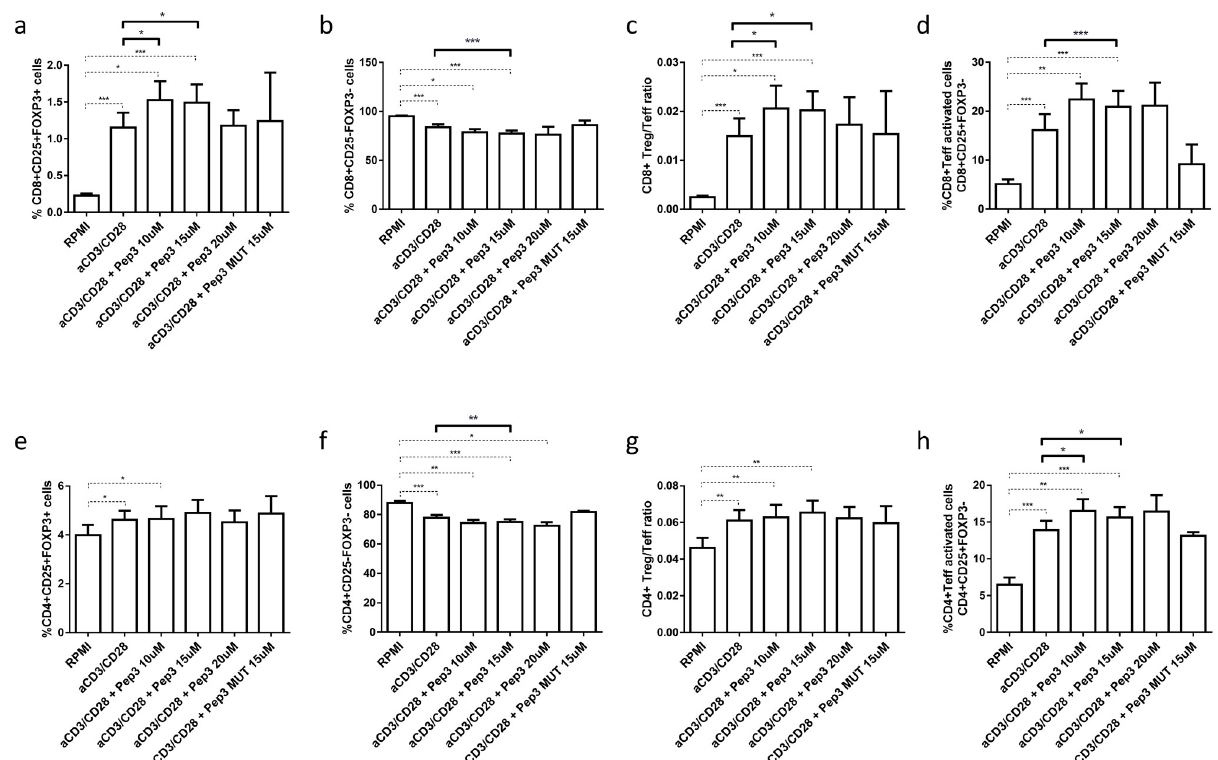
Fig 2. Frequency of T cell populations in PBMC from HD upon treatment with peptide 3 and subsequent stimulation with anti-CD3/CD28 beads for 6 days. Flow-cytometry analysis of HD PBMC following 10, 15 and 20 μ M treatment relative to Pep3 and 15 μ M treatment relative to Pep3 MUT and subsequent stimulation for six days with anti-CD3/CD28 beads. Graphs show the percentage of CD8+ Treg as CD8+ CD25+FOXP3+ cells ( a ), CD8+ Teff as CD8+ CD25-FOXP3- cells ( b ), CD8+ Treg/Teff ratio ( c ), CD8+ Teff activated cells as CD8+ CD25+FOXP3- cells ( d ), CD4+ Treg as CD4+ CD25+FOXP3+ cells ( e ), CD4+ Teff as CD4+ CD25-FOXP3- cells ( f ), CD4+ Treg/Teff ratio ( g ), CD4+ Teff activated cells as CD4+ CD25+FOXP3- cells ( h ). Percentages were obtained as described for the previous experiments (see legend to Fig 1). Values correspond to mean frequency ± SEM of 14 HD. � p < 0.05, �� p < 0.01, ��� p <